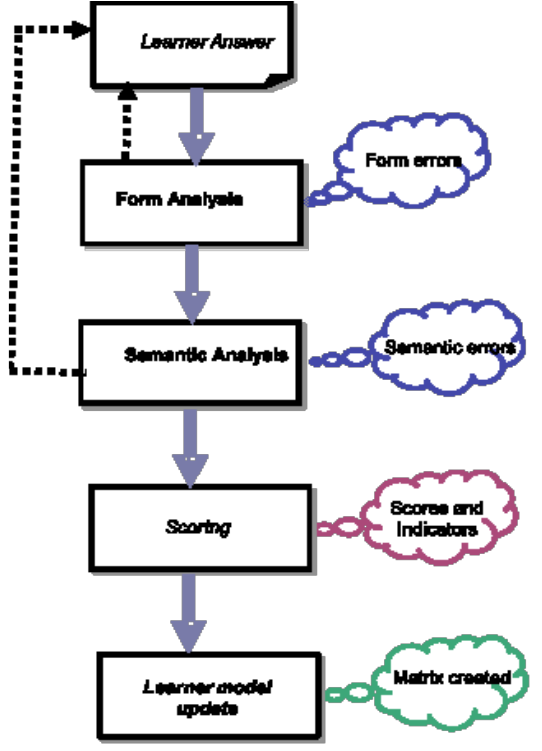
Fig.1. The evaluation process with